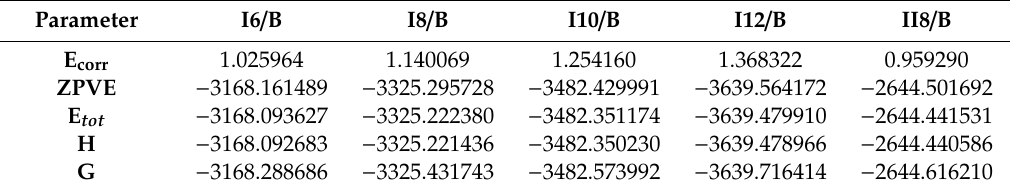
Table 2. Thermal Parameters (Hartree / Particle) of I6 / B, I8 / B, I10 / B, I12 / B and II8 / B. Parameter I6 /